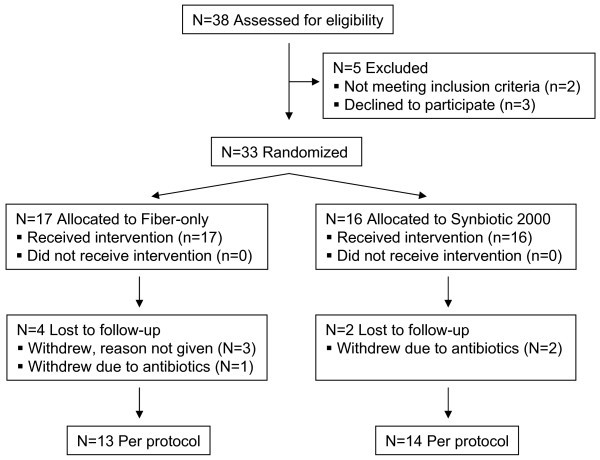
Participant Flow Diagram.